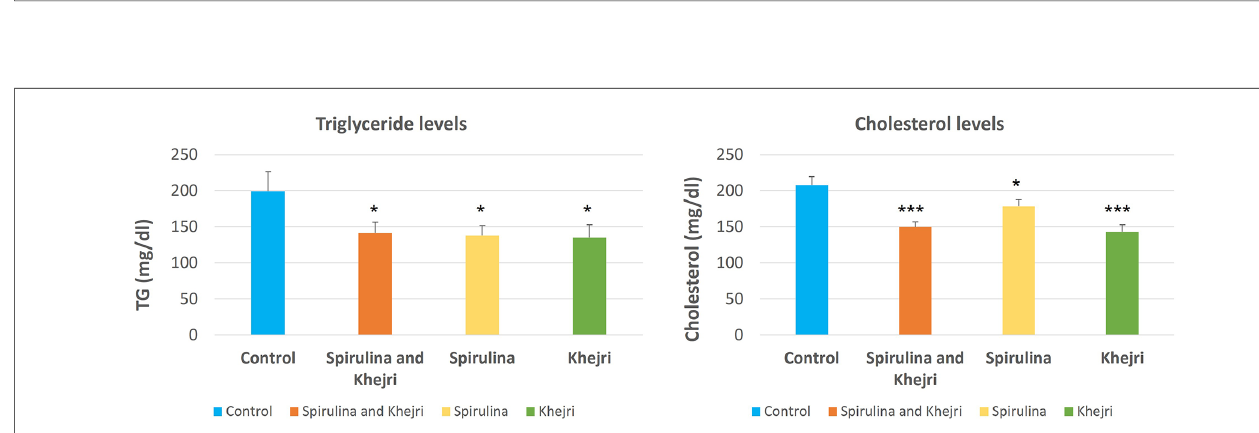
FIGURE 4 Triglyceride and cholesterol levels comparison in cricket players between all the 4 groups: Group 1 ( n =10): both supplements Spirulina and Khejri B, Group 2 ( n =10): supplement Spirulina, Group 3 ( n =10): supplement Khejri, Group 4 ( n =10): control, * p <0.05, ** p <0.01, *** p <0.001.